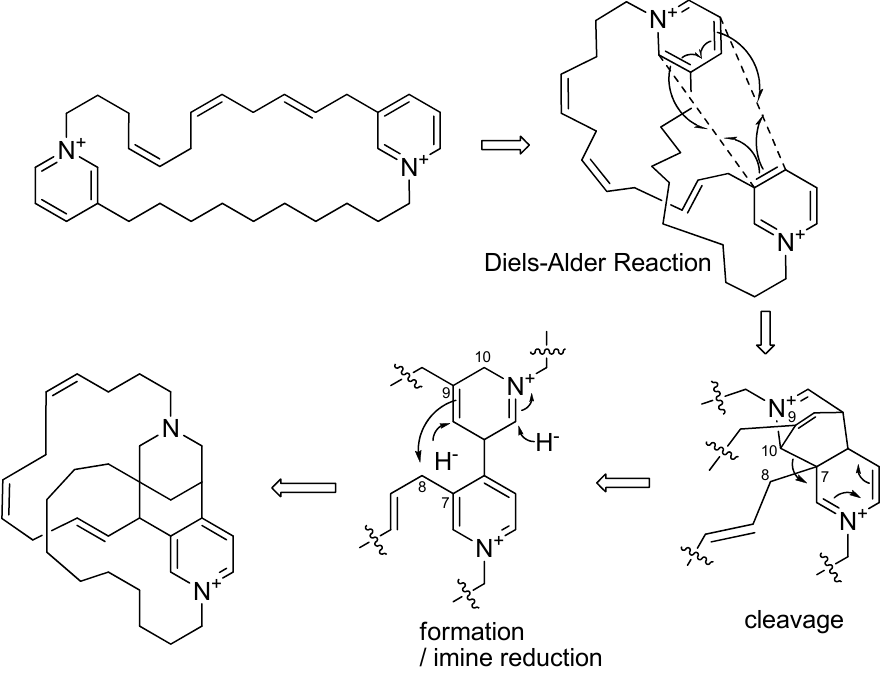
Figure 4. Plausible biosynthesis of 1 .